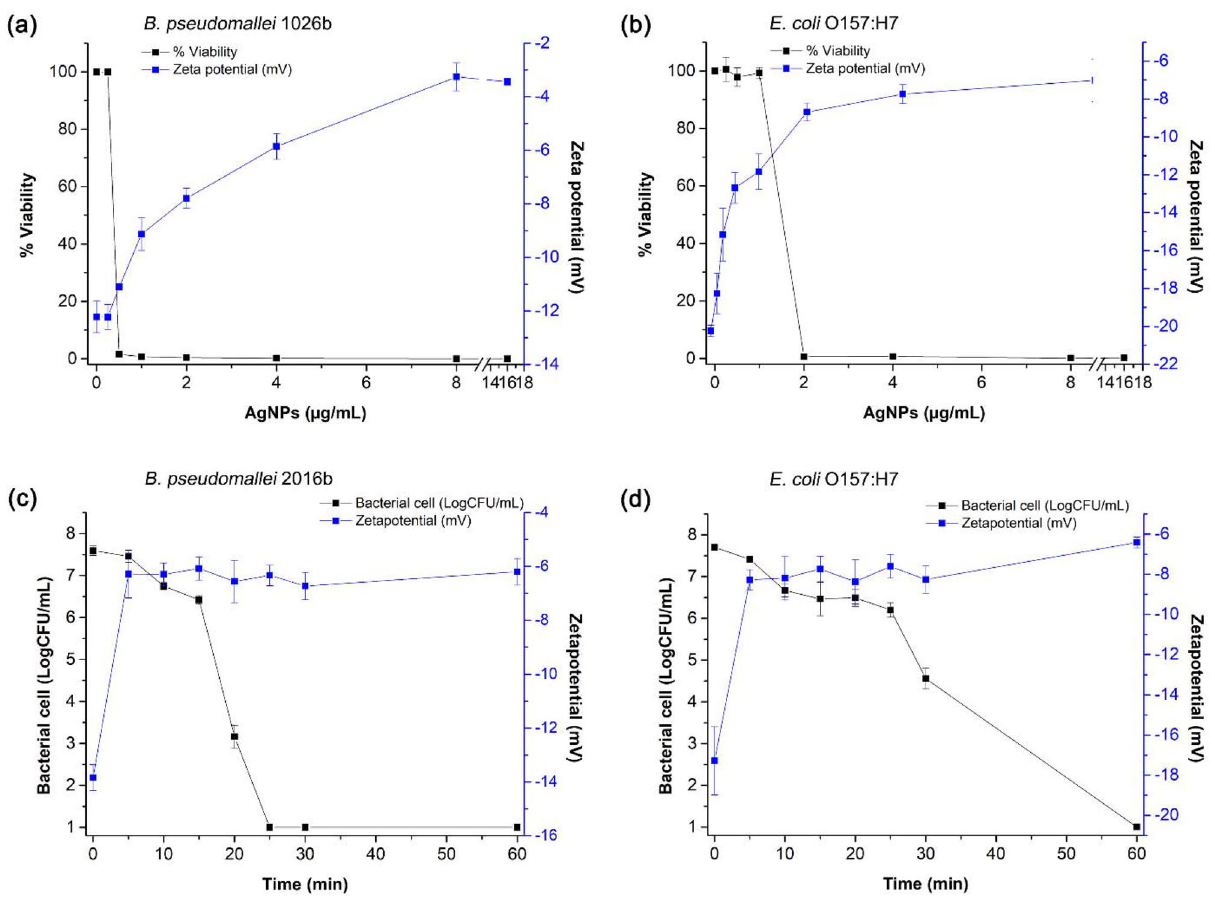
Figure 4. Effect of andro-AgNPs on bacterial viability and cell surface charge of B. pseudomallei 1026b ( a ) and E. coli O157:H7 ( b ). The bacteria were treated with andro-AgNPs concentrations in the range 0.25–16 μg/ mL. The black line corresponds to the percentage of viable bacterial cells in the presence of increasing andro- AgNPs concentration, whereas the cell surface zeta potential is indicated by the blue line. Data represent the means ± standard errors for 6 samples. The correlation between cell membrane neutralization and cell viability over 60 min for B. pseudomallei 1026b ( c ) and E. coli O157:H7 ( d ) after introduction of 8 µg/mL of andro- AgNPs (1xMBC) at 37 °C. After incubation, the bacteria colony count and zeta potential were measured every 5 min. Data are represented as mean value ± standard error from two independent experiments carried out in triplicate ( n =